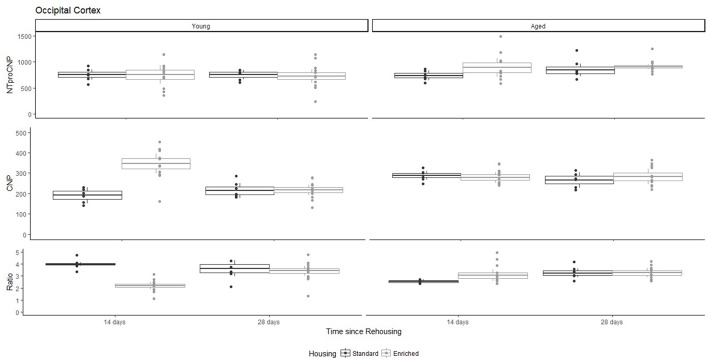
Concentration (femtomoles/g wet tissue) of NTproCNP (Top), CNP (Middle), and NTproCNP:CNP ratio (Bottom) within occipital cortex. Summary data is 20% trimmed means (resulting in a reduction of n = 2 for all groups), standard error (box) and 95% confidence interval (whisker), overlaid by individual data points. For NTproCNP: Aged rats > Young rats. For CNP: Young-Enriched-14-day > Aged overall > Other Young rats. For Ratio: Young-Enriched-14-day < Aged overall < Other Young rats.